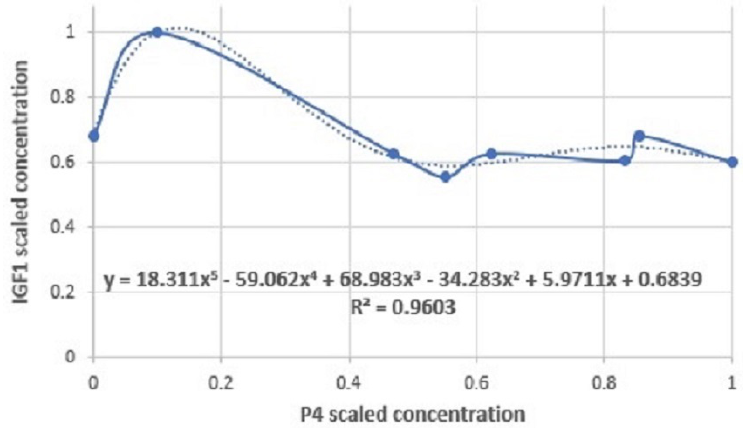
Figure 7. IGF1 as a function of